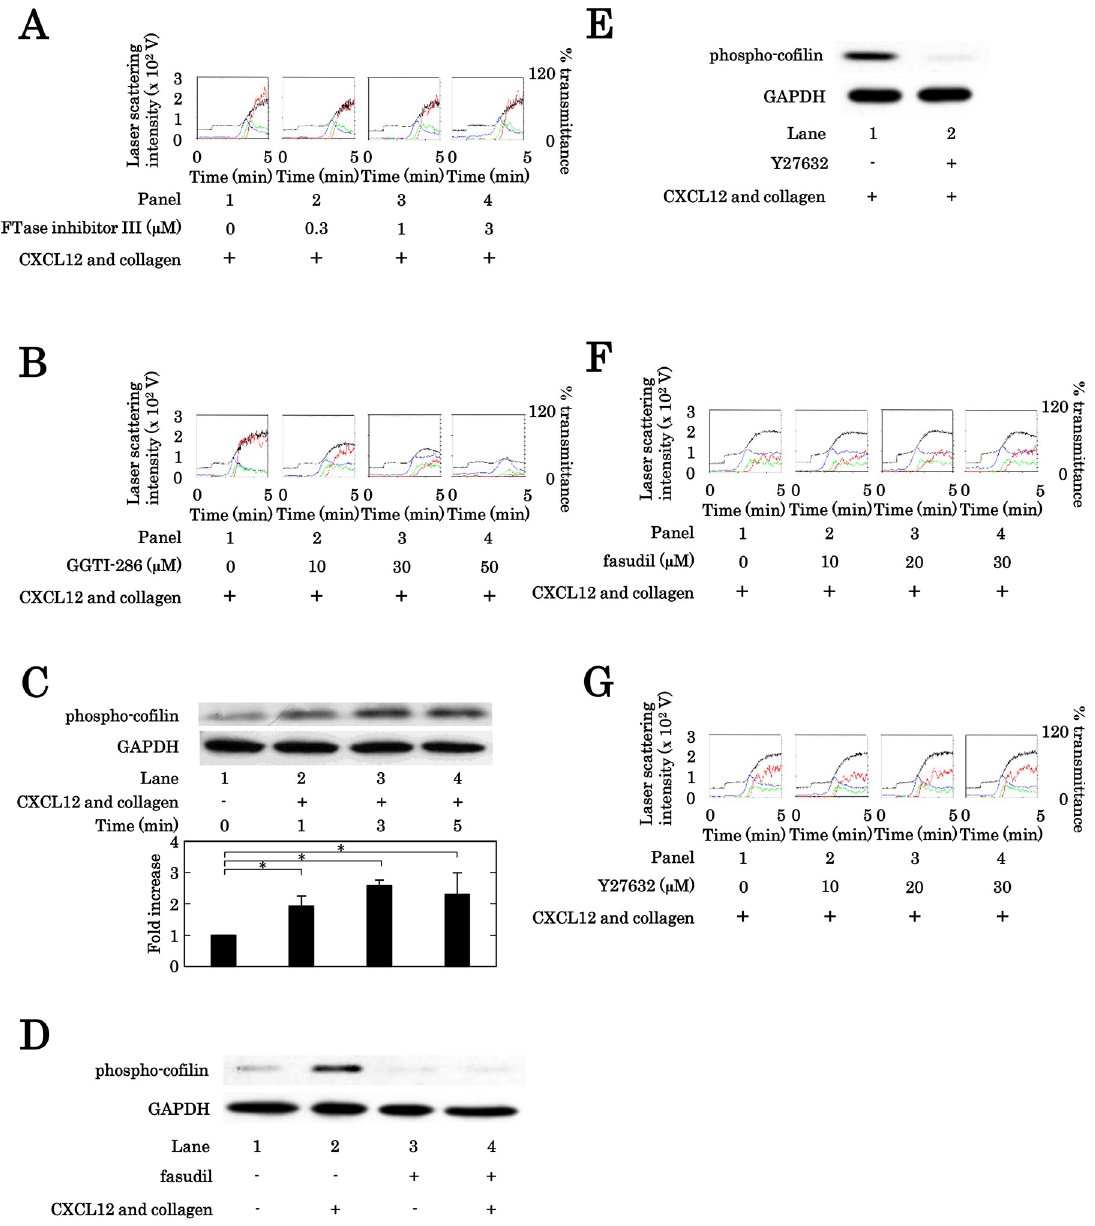
Fig 3. Effects of FTase inhibitor III, GGTI-286, fasudil and Y27632 on the platelet aggregation induced by simultaneous stimulation with subthreshold collagen and CXCL12. (A, B) PRP was pretreated with 0 μ M, 0.3 μ M, 1 μ M or 3 μ M of FTase inhibitor III (A), 0 μ M, 10 μ M, 30 μ M or 50 μ M of GGTI-286 (B) for 3 min, and then stimulated simultaneously by the combination of 0.3– 0.35 μ g/ml of collagen and 10 ng/ml of CXCL12 for 5 min. The representative results from 3 independent individuals are shown. The black line indicates the percentage of transmittance of each sample (isolated platelets recorded as 0%, and platelet-poor plasma recorded as 100%). The blue line indicates small aggregates (9–25 μ m); green line, medium aggregates (25–50 μ m); red line, large aggregates (50– 70 μ m). (C) PRP was simultaneously stimulated by 0.2 μ g/ml of collagen and 10 ng/ml of CXCL12 for the indicated time, and the reaction was terminated by the addition of ice-cold EDTA (10 mM) solution. The levels of phosphorylated cofilin in the lysate of platelets were determined by the Western blot analysis using the antibodies against phospho-coffilin or GAPDH. The representative data from 3 independent experiments are shown. The histogram shows a quantitative representation of the combination-induced levels obtained from a densitometric analysis. The phosphorylation is expressed as the fold increase compared to the levels of lane 1. Each value represents the mean ± SEM of 3 times independent experiments. � p < 0.05, compared to the value of lane 1. (D, E) PRP was pretreated for 3 min with 30 μ M of fasudil (D), 30 μ M of Y27632 (E) or vehicle, and then stimulated simultaneously by the combination of 0.15 μ g/ml of collagen and 10 ng/ml of CXCL12 for 3 min. The levels of phosphorylated cofilin in the lysate of platelets were determined by the Western blot analysis as described above. The representative data of triplicate independent determinations are shown. (F, G) PRP was